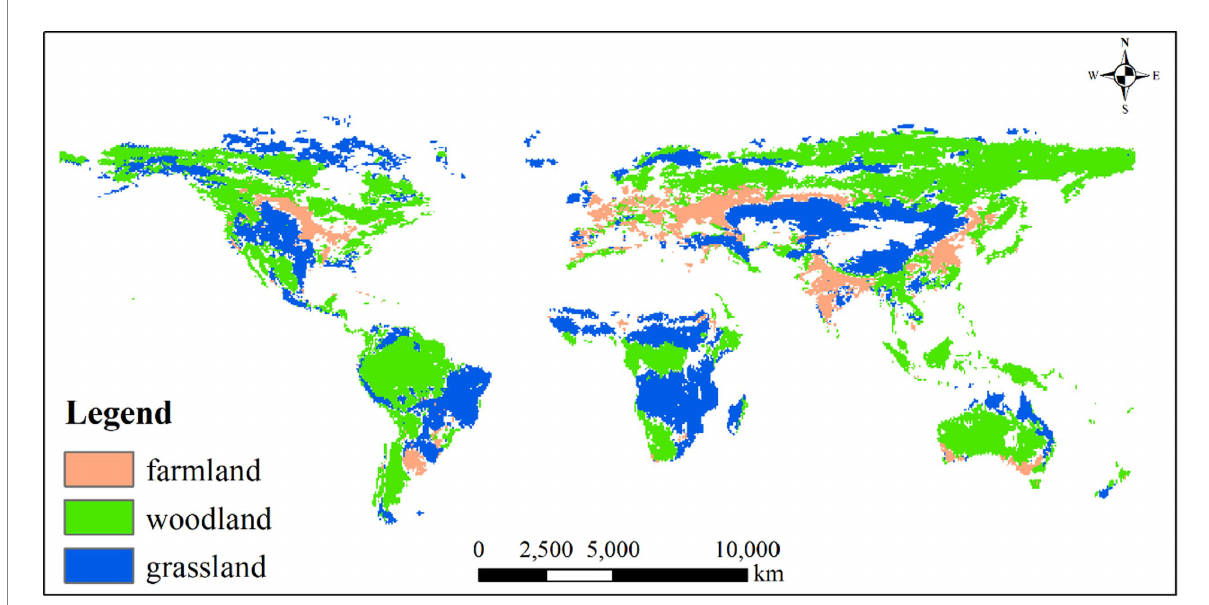
FIGURE 1 Woodland, grassland and farmland unchanged from